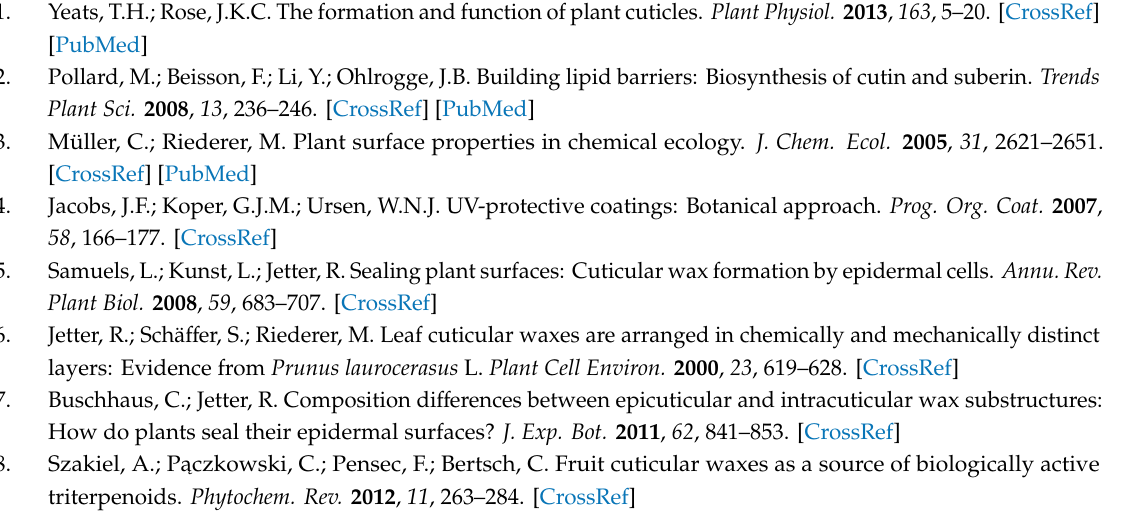
Supplementary Materials: Table S1: Retention times and characteristic ions of mass spectra of identified steroids and triterpenoids. Figure S1: Changes in the content of triterpenoids in cuticular waxes during lingonberry Vaccinium vitis-idaea fruit development. Figure S2: Changes in the content of triterpenoids in cuticular waxes during bilberry Vaccinium myrtillus fruit development. Figure S3: Changes in the content of triterpenoids in cuticular waxes during strawberry tree Arbutus unedo fruit development. Figure S4: Changes in the content of triterpenoids in cuticular waxes during honeysuckle Lonicera caerulea fruit